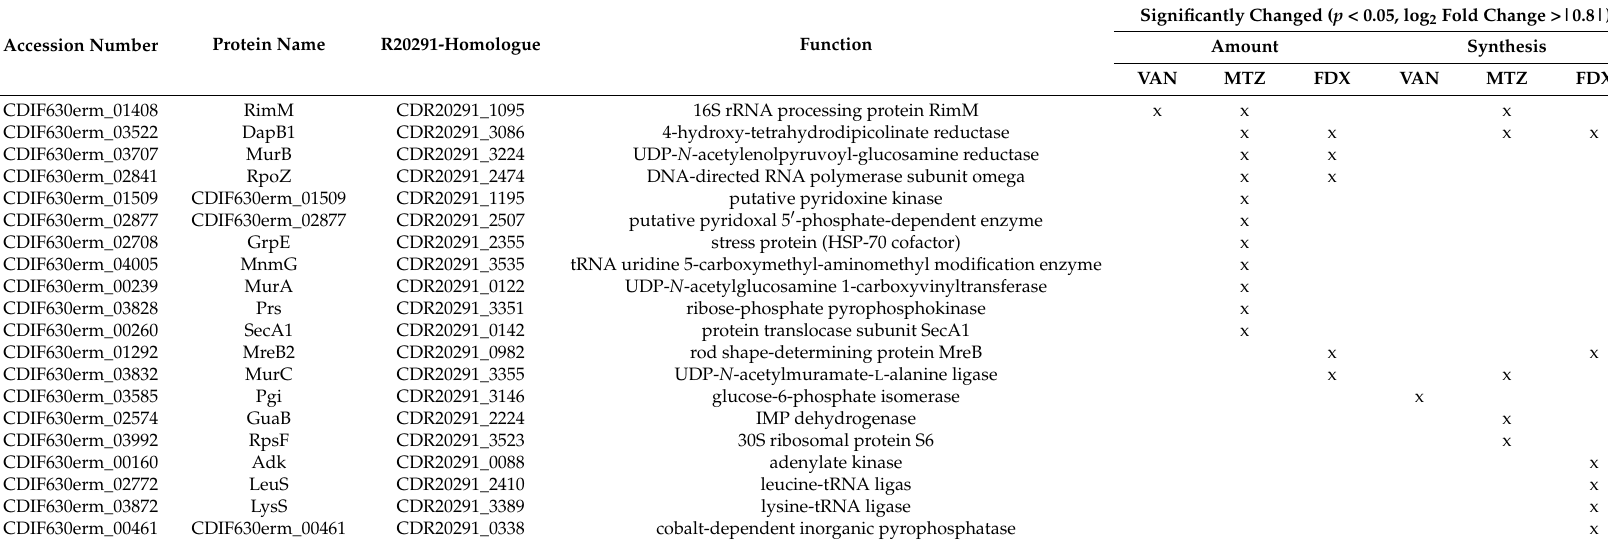
Table 1. This table lists all proteins which were significantly altered ( p -value < 0.05, average log 2 fold change >|0.8|) in either synthesis or amount after treatment of C. difficile 630 ∆ erm with sublethal concentrations of vancomycin (VAN), metronidazole (MTZ) or fidaxomicin (FDX), respectively. A protein was assumed to be essential when it showed reciprocal best hits to its homologue in C. difficile R20291 after an analysis with Proteinortho